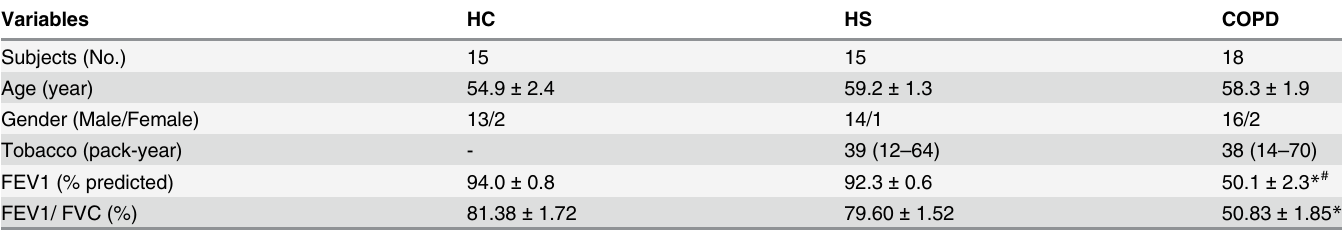
Table 1. Demographics and clinical characteristics of all